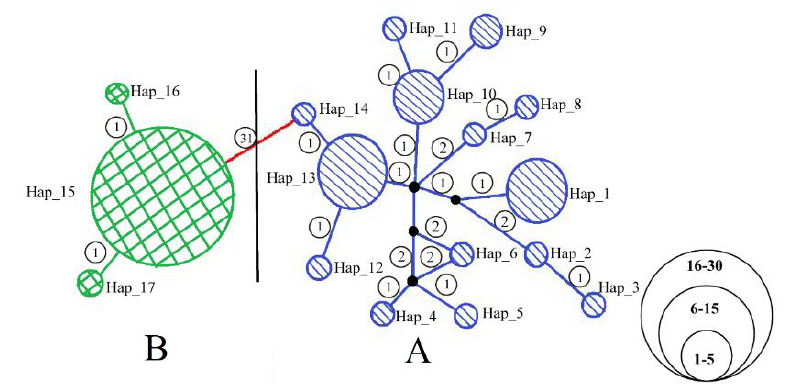
Figure 3. Unrooted network of 17 haplotypes in 65 A. triastriatus individuals from 35 locations (lineage A: blue; lineage B: green) based on 679 bp of a fragment of the mitochondrial COI gene. Each circle in the haplotype network corresponds to one haplotype, and its size is proportional to its frequency among samples. The numbers along branches represent the number of mutations between haplotypes. Dark dots are median vectors that represent intermediate haplotypes that were not sampled or are extinct